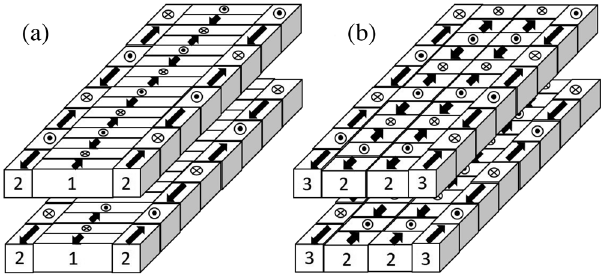
FIG. 1. Schematic illustrations of (a) the typical Figure 8 undulator and (b) the typical APPLE-Knot